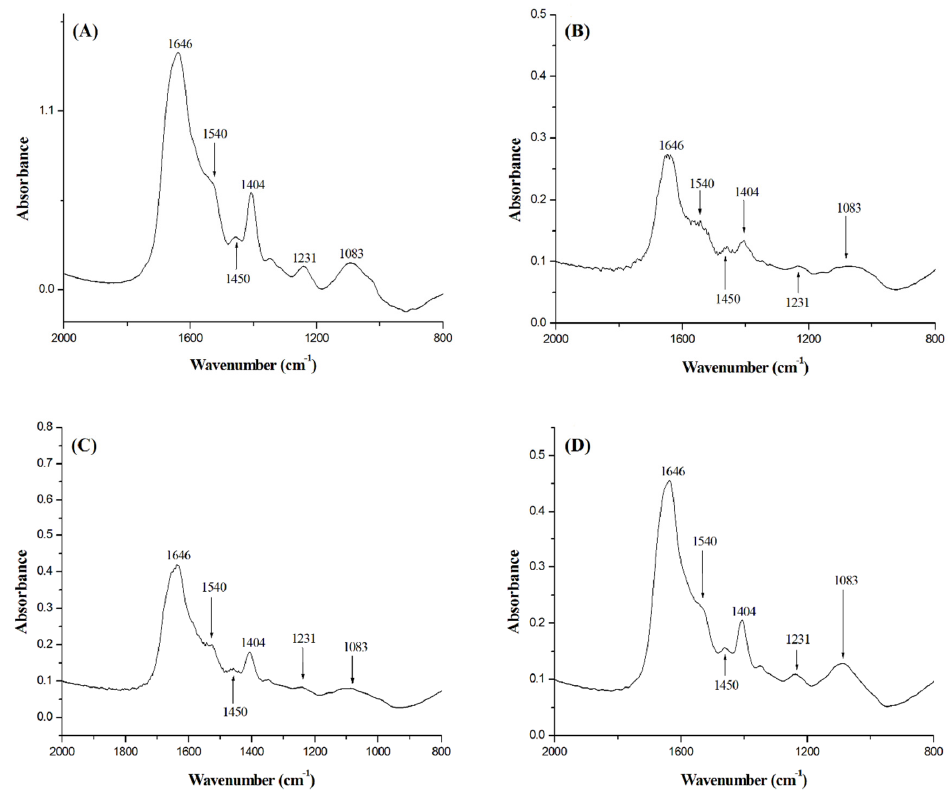
Figure 5. FT-IR spectra of B. subtilis cells after 30 min treatment with ( A ) no compounds added; ( B ) nisin (5 µ g / mL); ( C ) BC1 (50 µ g / mL); and ( D ) T9A (40 µ g /